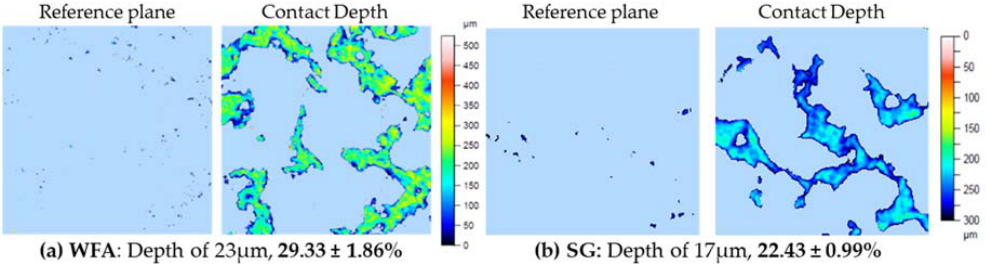
Figure 7. Real contact area quantification from wear depth. Reference plane and contact depth slices for ( a ) WFA and ( b ) SG alumina.